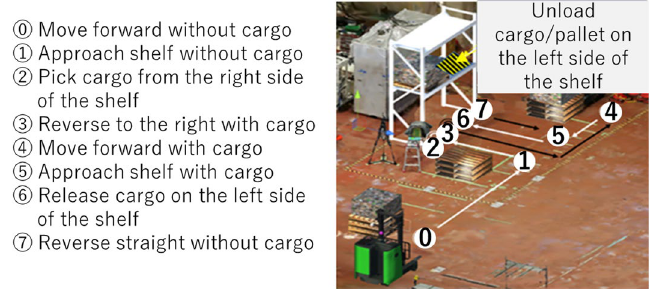
Figure 2. The experiment task consists of basic forklift operations in a virtual environment such as moving forward, backward, approach shelf, loading and unloading.